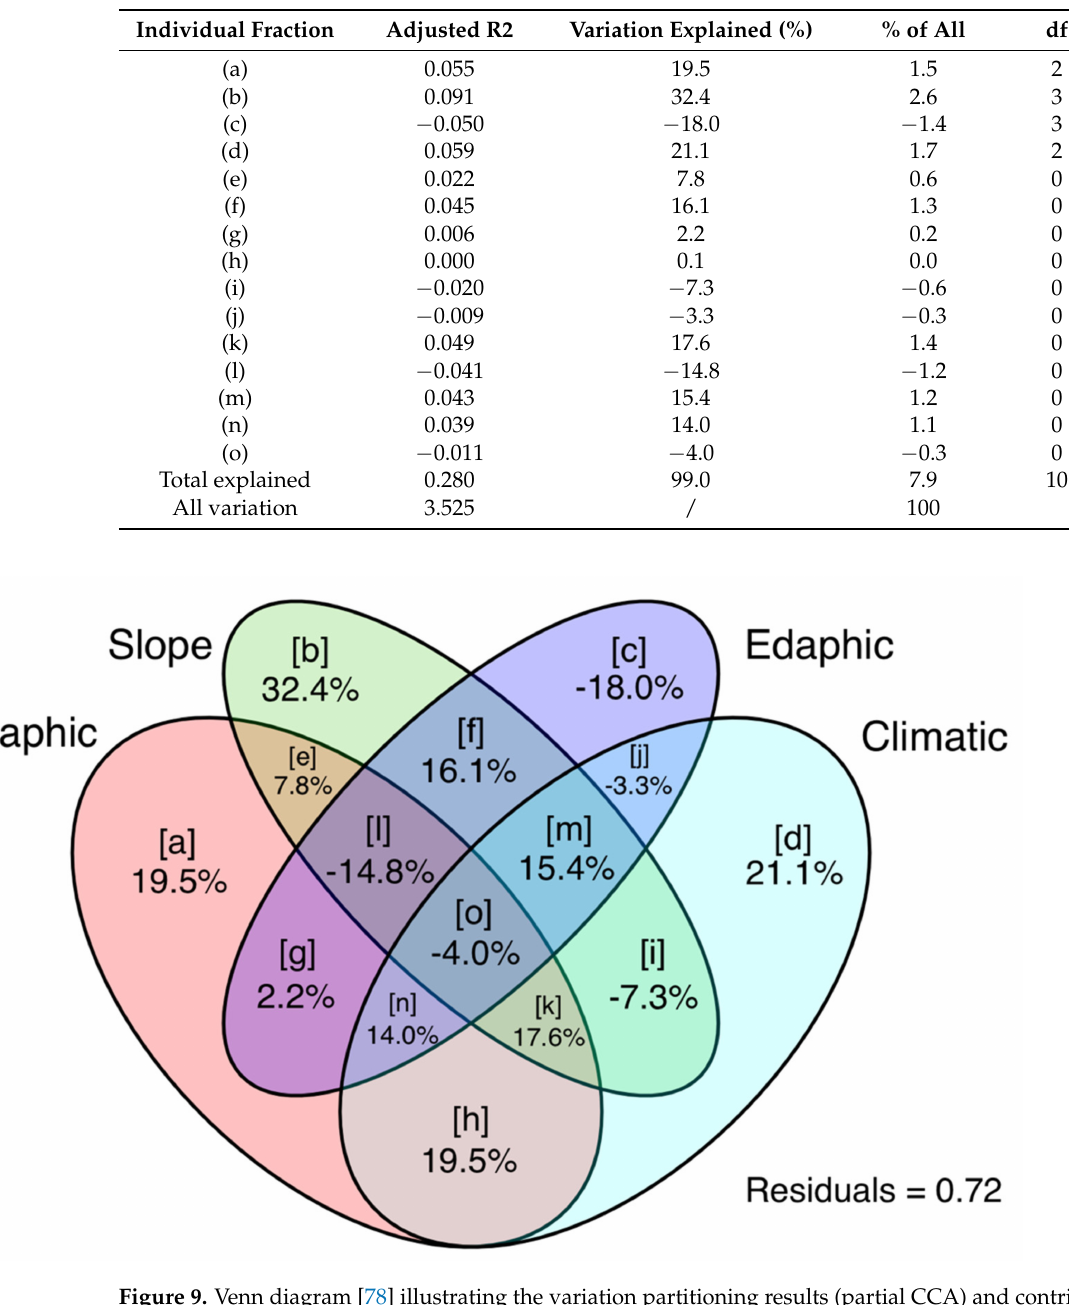
Table 4. Variation partitioning (partial CCA) of four variable groups studied (Figure 9).